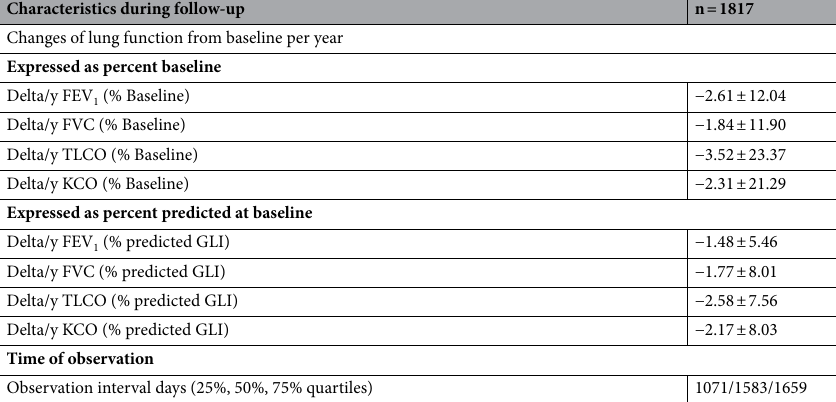
Table 2. Changes of lung function during follow-up. The changes in lung function (delta/y) are expressed as a raw percent changes per year relative to baseline, moreover as changes per year relative to baseline in terms of percent predicted at baseline in order to reduce variation. Only the latter were used for analysis. FEV 1 = forced expiratory volume in 1 s; FVC = functional vital capacity; TLCO = diffusing capacity for carbon monoxide; KCO = CO transfer